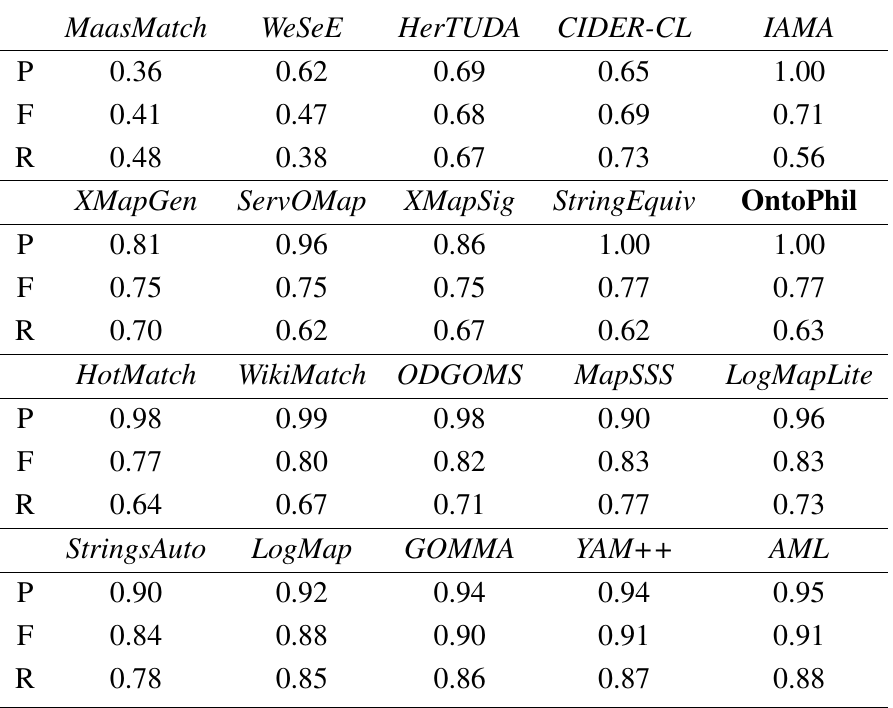
Table 3. Results obtained in the OAEI-13 anatomy track compared with OntoPhil (ordered by